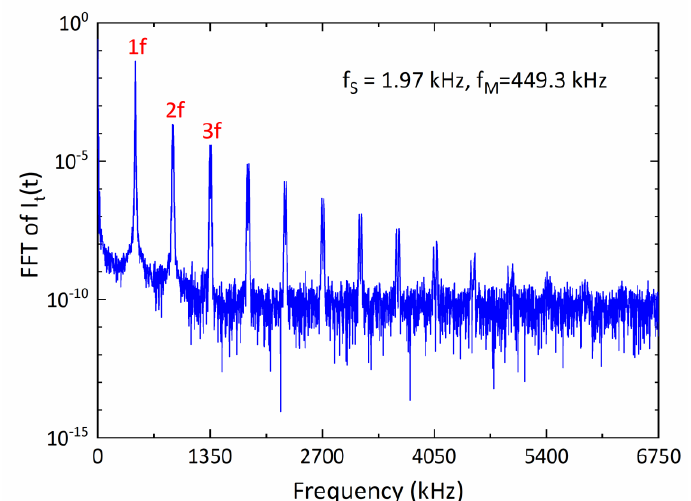
Figure 6. Frequency spectrum of a measured detector signal in a scanned-WMS experiment. The first three harmonic signals are marked in the picture where 1f = ~450 kHz, 2f = ~900 kHz, and 3f = ~1350 kHz.